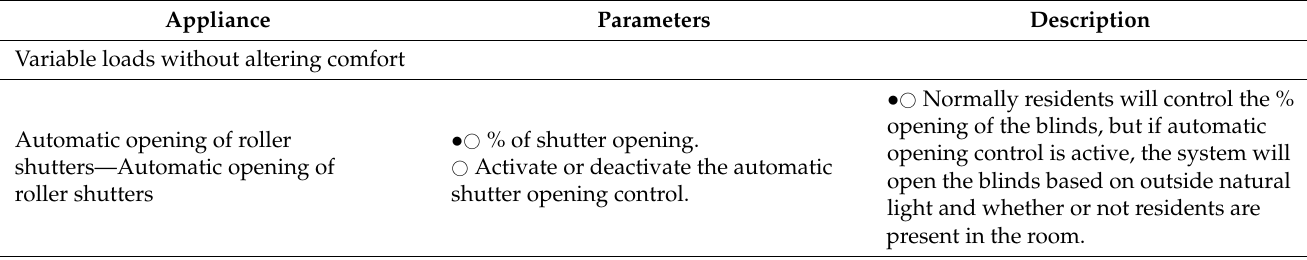
Table 2. Programmable parameters associated with loads of each appliance. System managed control: “ • ” or “ (cid:4) ”. Resident-managed control: “ Appliance Parameters